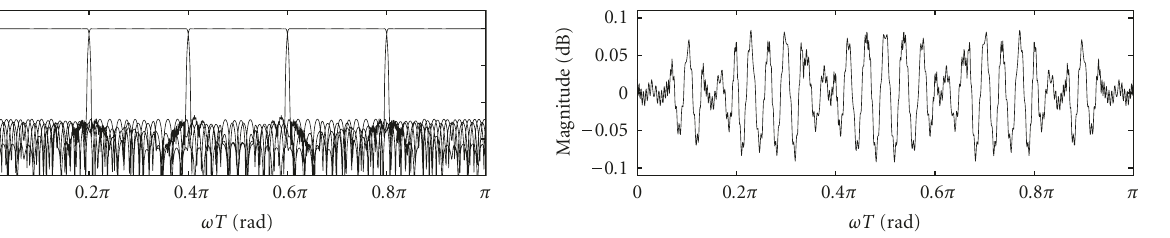
Figure 7: Magnitude responses of the analysis filters without the nonlinear optimization procedure with N G = 47 and N F = 102, Example 1.